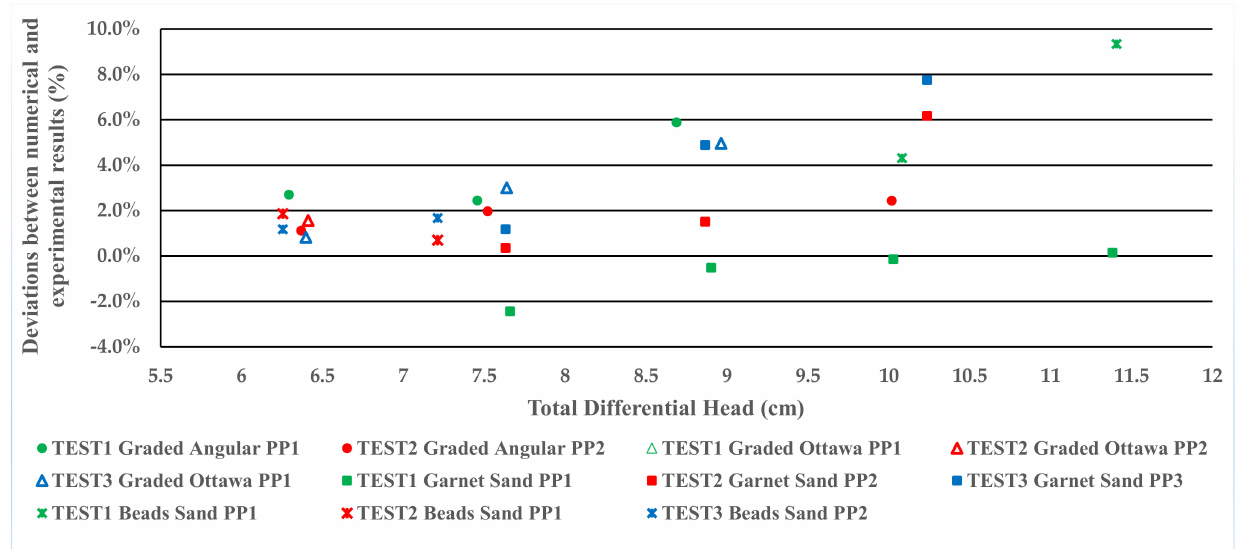
Figure 12. Variations between laboratory testing and numerical analysis for the four different types of sands. (Test 1 graded angular PP1 represents the sensor PP1 in the first test of graded angular sand which was applied for